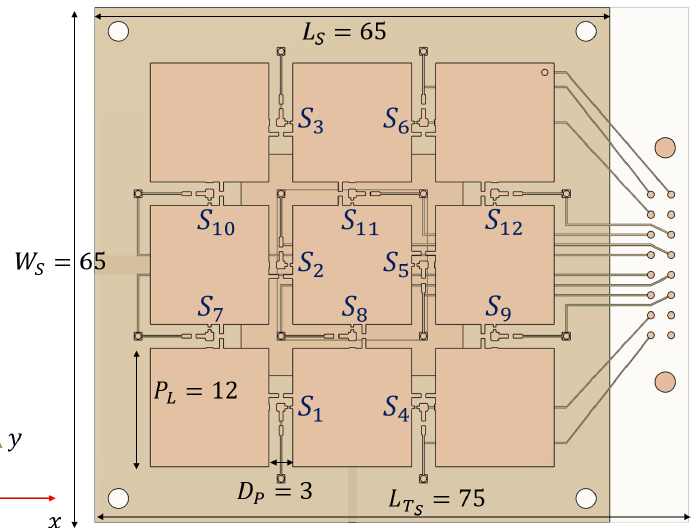
Figure 11. Parasitic-Layer-based